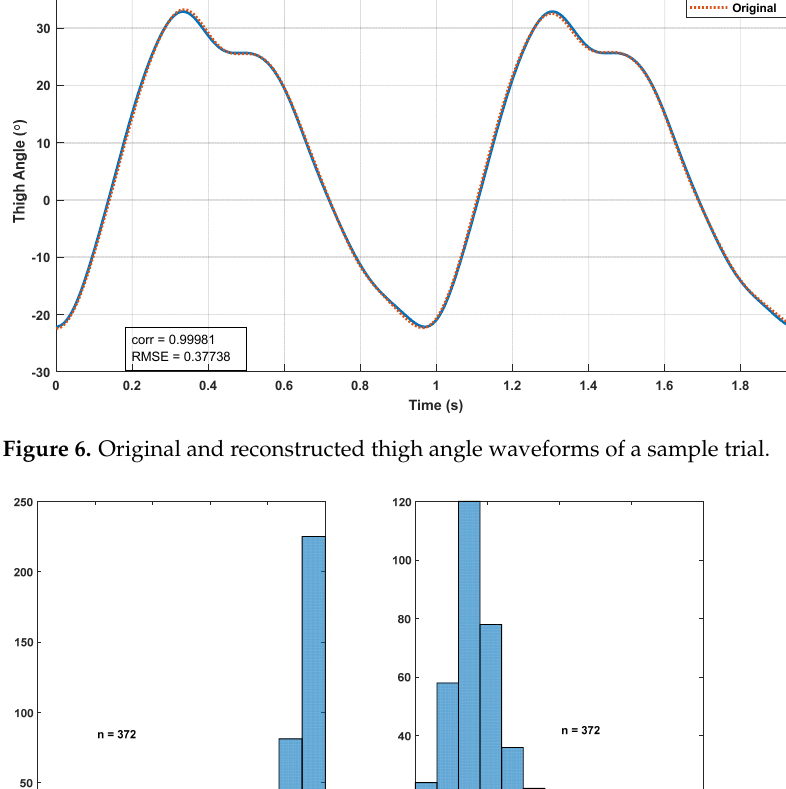
Figure 9. Distributions of initial phases of first five harmonics for all female and male trials. The fundamental frequencies of the FFT, i.e., the stride frequencies of females, were lower than those of the males in the trials. The peak stride frequency for males was about 0.925 Hz, while for females it was close to 1 Hz. The distributions of the fundamental stride frequencies for female and male subjects are shown in Figure 10. These indicate that, in the sample, the self-selected walking speed of males was 7.5% slower. The stride frequency was also computed using the stride time and compared with the fundamental frequency extracted from the spectrum. The error in the stride frequencies estimated us- ing stride time compared to the fundamental frequency was 0.0479% (± 0.0029%) over a total of 750 strides for all subjects, which indicates that the results derived when esti- mating the stride frequency using stride time are accurate.